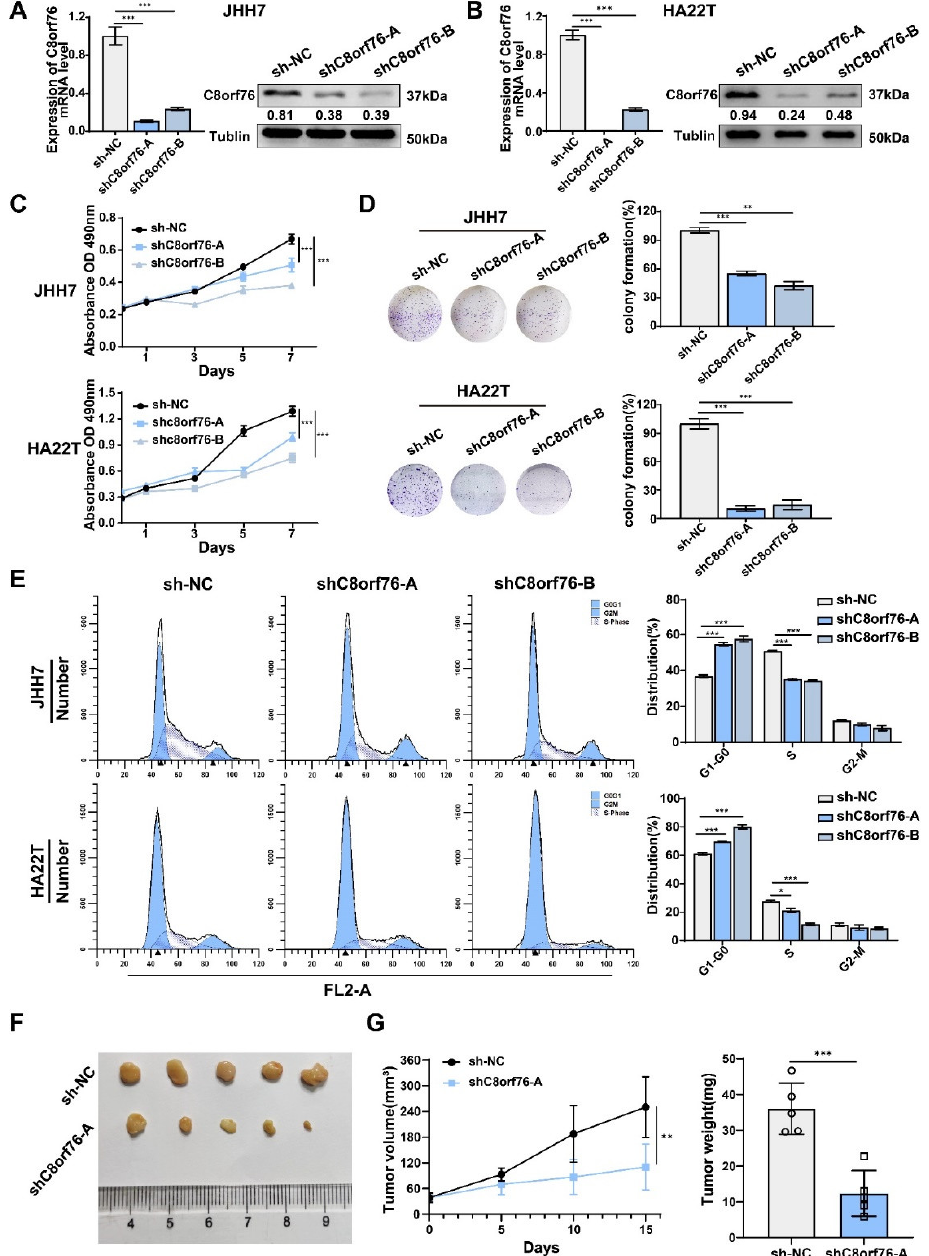
Figure 2. C8orf76 knockdown inhibits liver cancer cell growth, colony formation and cell cycle. ( A , B ) Relative C8orf76 mRNA and protein level in HCC cell lines with or without shC8orf76 transfection (n = 3). ( C , D ) C8orf76 knockdown significantly inhibited cell proliferation and impaired